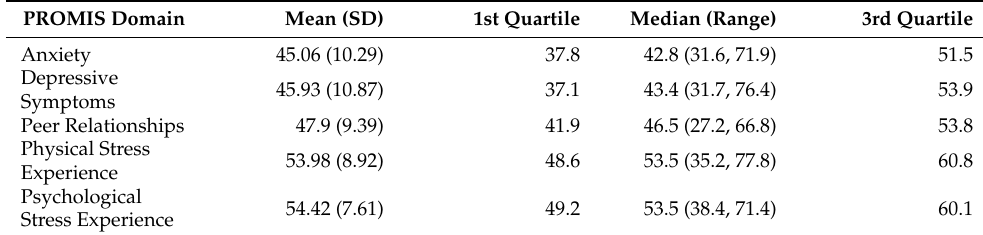
Table 2. Summary of PROMIS domain T scores for all